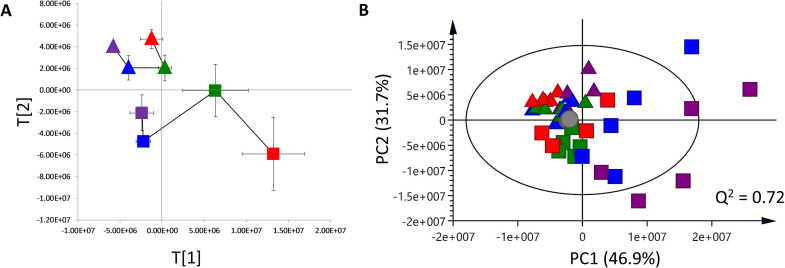
Principal Component Analysis (PCA) of 1H NMR spectral data obtained from leaf (triangle) and bark (square) of Dipterocarpus alatus at 2 (purple), 7 (blue), 15 (green), 25 (red) years and Quality Control (QC) samples (grey).A: time-trajectory PCA plot. Data are shown as average principal component score±SD. B: PCA score plot of all groups.